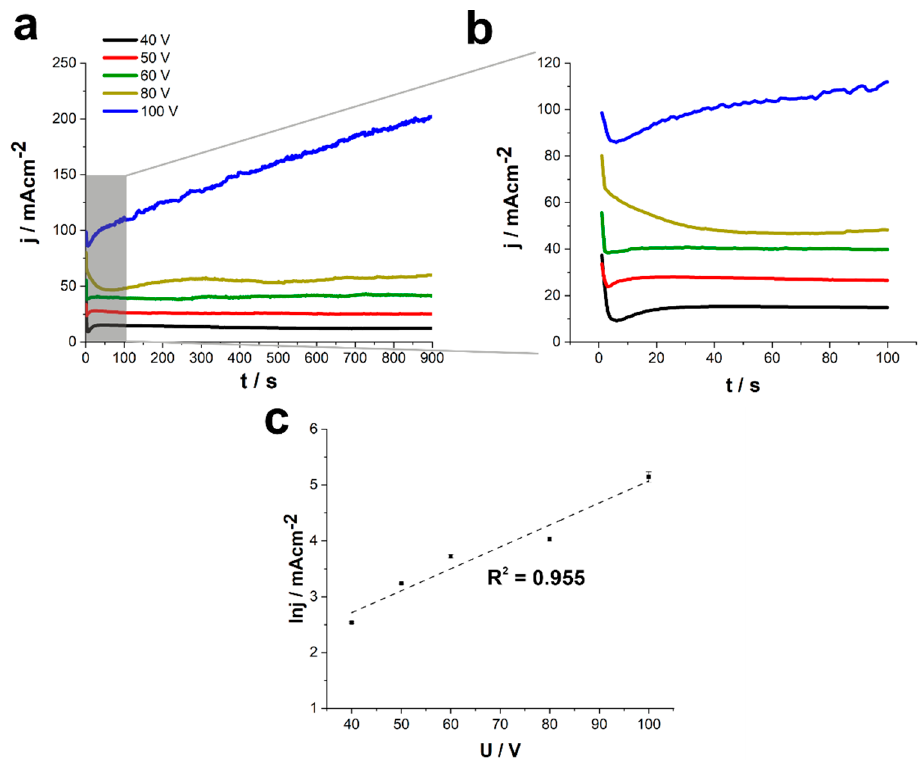
Figure 5. ( a ) Current density vs. time curves recorded for the anodization of Ti15Mo alloy in the ethylene glycol-based electrolyte at different potentials for 15 min. ( b ) Close-up for the initial 100 s of the process. ( c ) The natural logarithm of the steady-state current value vs. anodization potential with a linear fit.